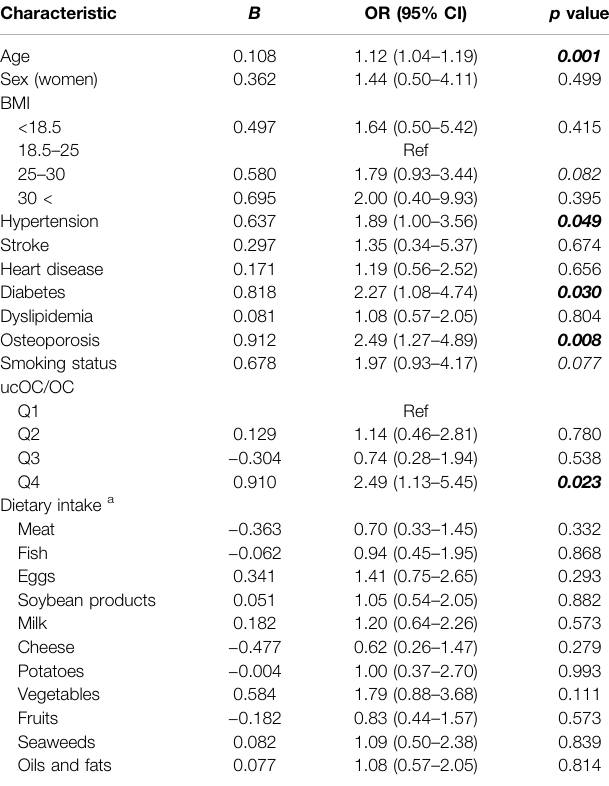
TABLE 2 | Association of characteristics with frailty.